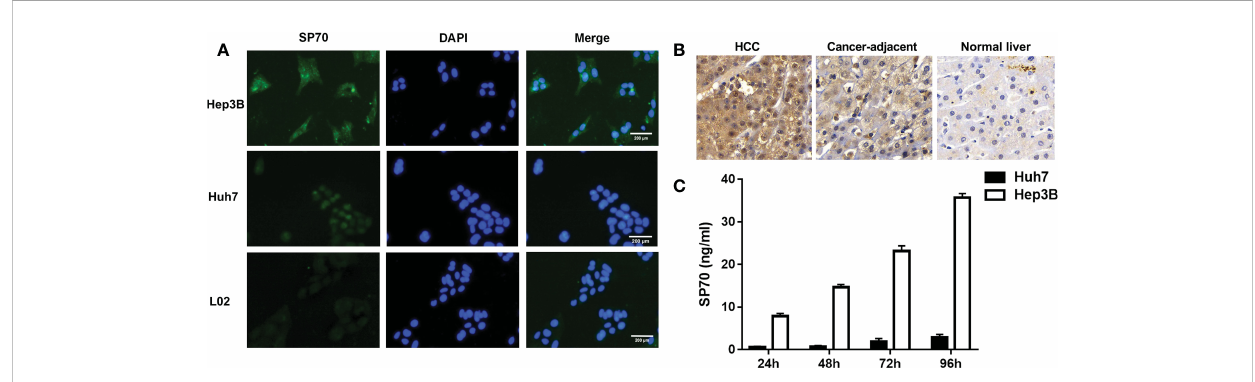
FIGURE 1 The expression of SP70 in HCC cells and tissues. (A) Immuno fl uorescence analysis showed that SP70 was highly expressed in Hep3B cells, mainly expressed in the nucleus of Huh7 cells and lowly expressed in L02 cells; (B) Immunohistochemistry staining showed that SP70 was highly expressed in HCC tissues (×400); (C) Levels of SP70 in culture supernatant increased further with the proliferation of HCC